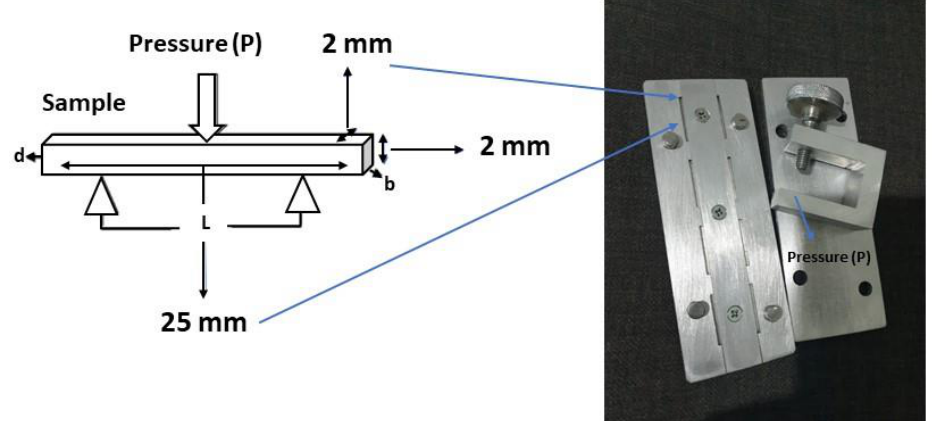
Figure 2. The compression molding of nanocomposite sample for flexural test and ME. Table 1. Experimental setup of the composite samples in comparison with only MMA.